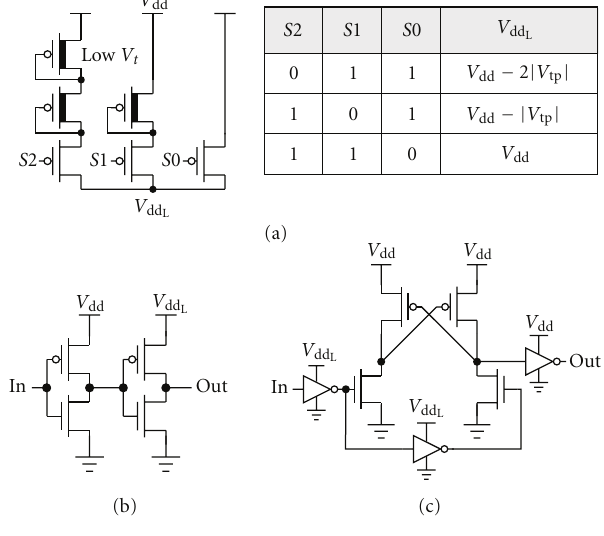
Figure 11: (a) Low swing voltages. (b) Low swing driver. (c) Level